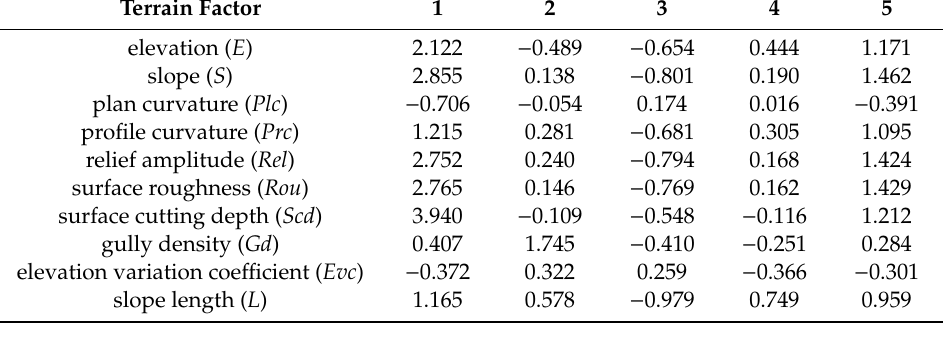
Table 4. The final cluster center of normalized terrain factors.